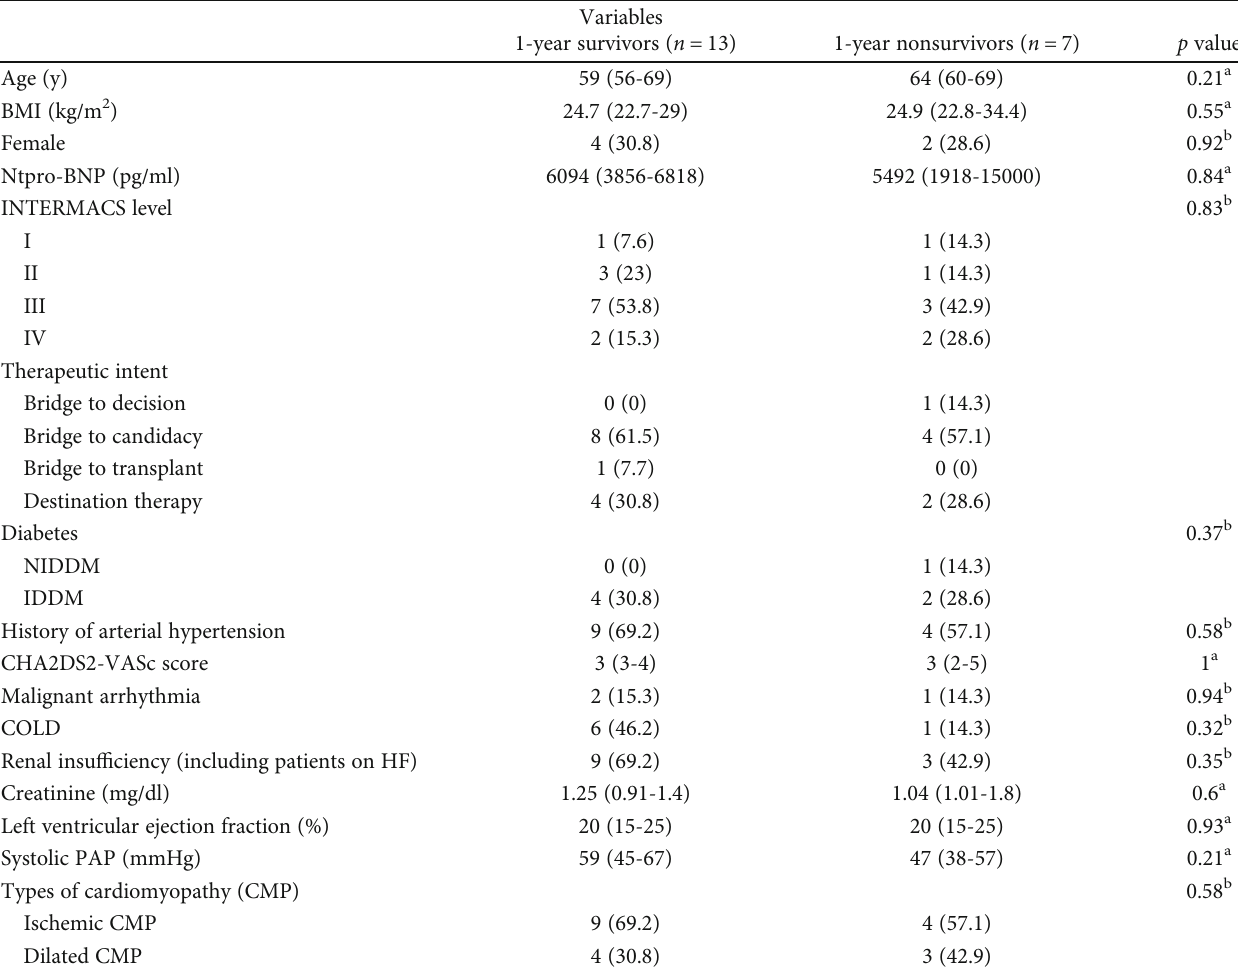
Table 1: Baseline characteristics of the study population ( n = 20